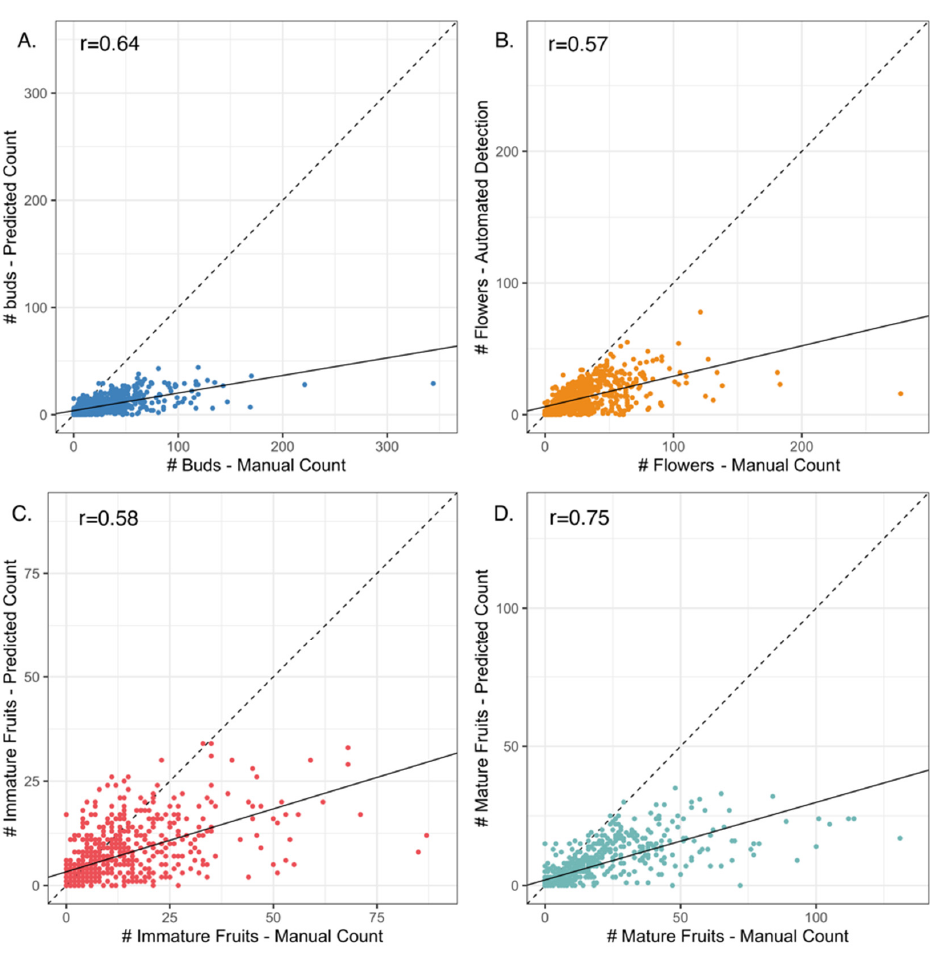
Figure 1. Bi-variate relationship between the number (#) of organs predicted by the machine-learning model vs. those counted manually by human observers for ( A ) buds, ( B ) flowers, ( C ) immature fruits, and ( D ) mature fruits. The dashed diagonal line shows a hypothetical 1:1 relationship where the manual and true counts are the same. The solid line denotes the linear regression between predicted and manual counts. Summaries for each regression can be found in Table S2.